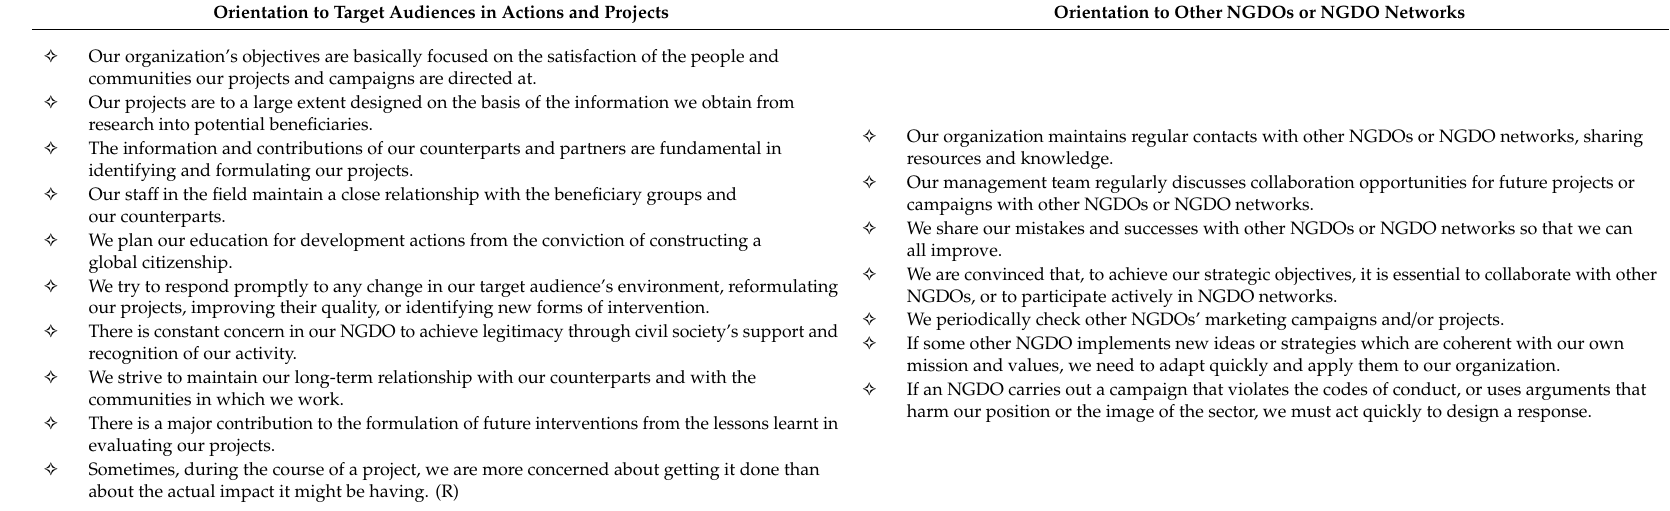
Table A1. Market orientation scale in accordance with the analysis made by the panel of